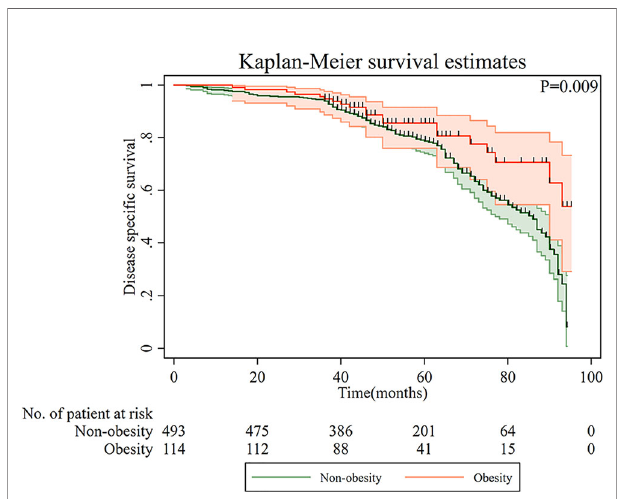
FIGURE 2 | Disease-speci fi c survival of patients with gastric cancer according to overweight/obesity.